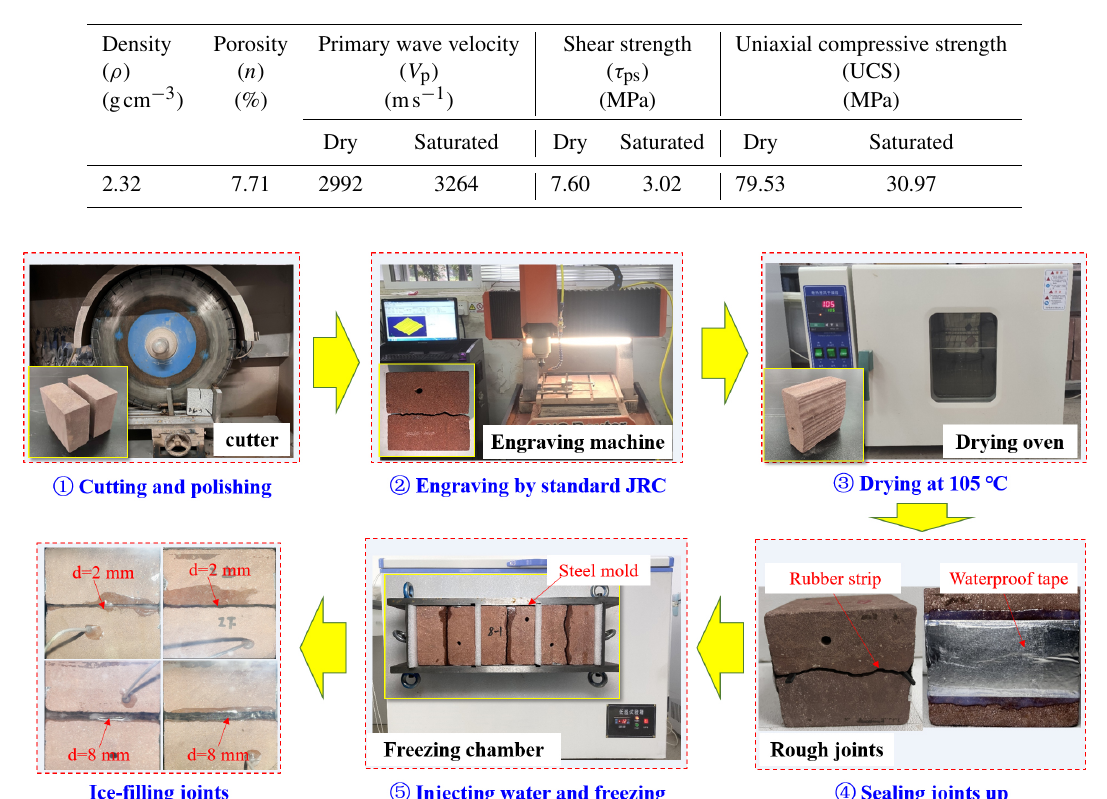
Figure 1. Preparation of ice-filled joints. The preparation steps are as follows: (1) cutting and polishing, (2) engraving by standard, (3) drying at 105 ◦ C, (4) sealing joints up, and (5) injecting water and